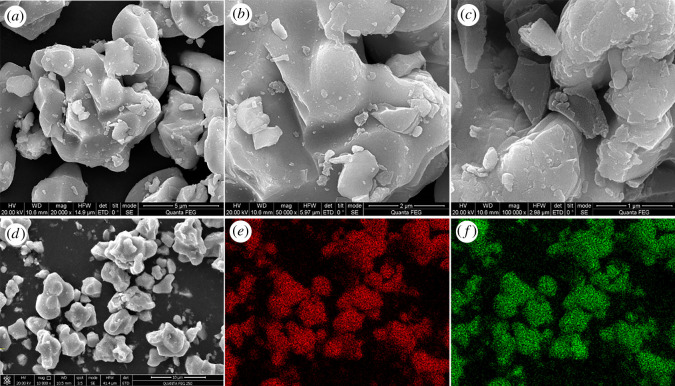
(a–d) Representative SEM image of MoSi2 ceramic; (e,f) representative elemental mapping analysis of MoSi2 ceramic.